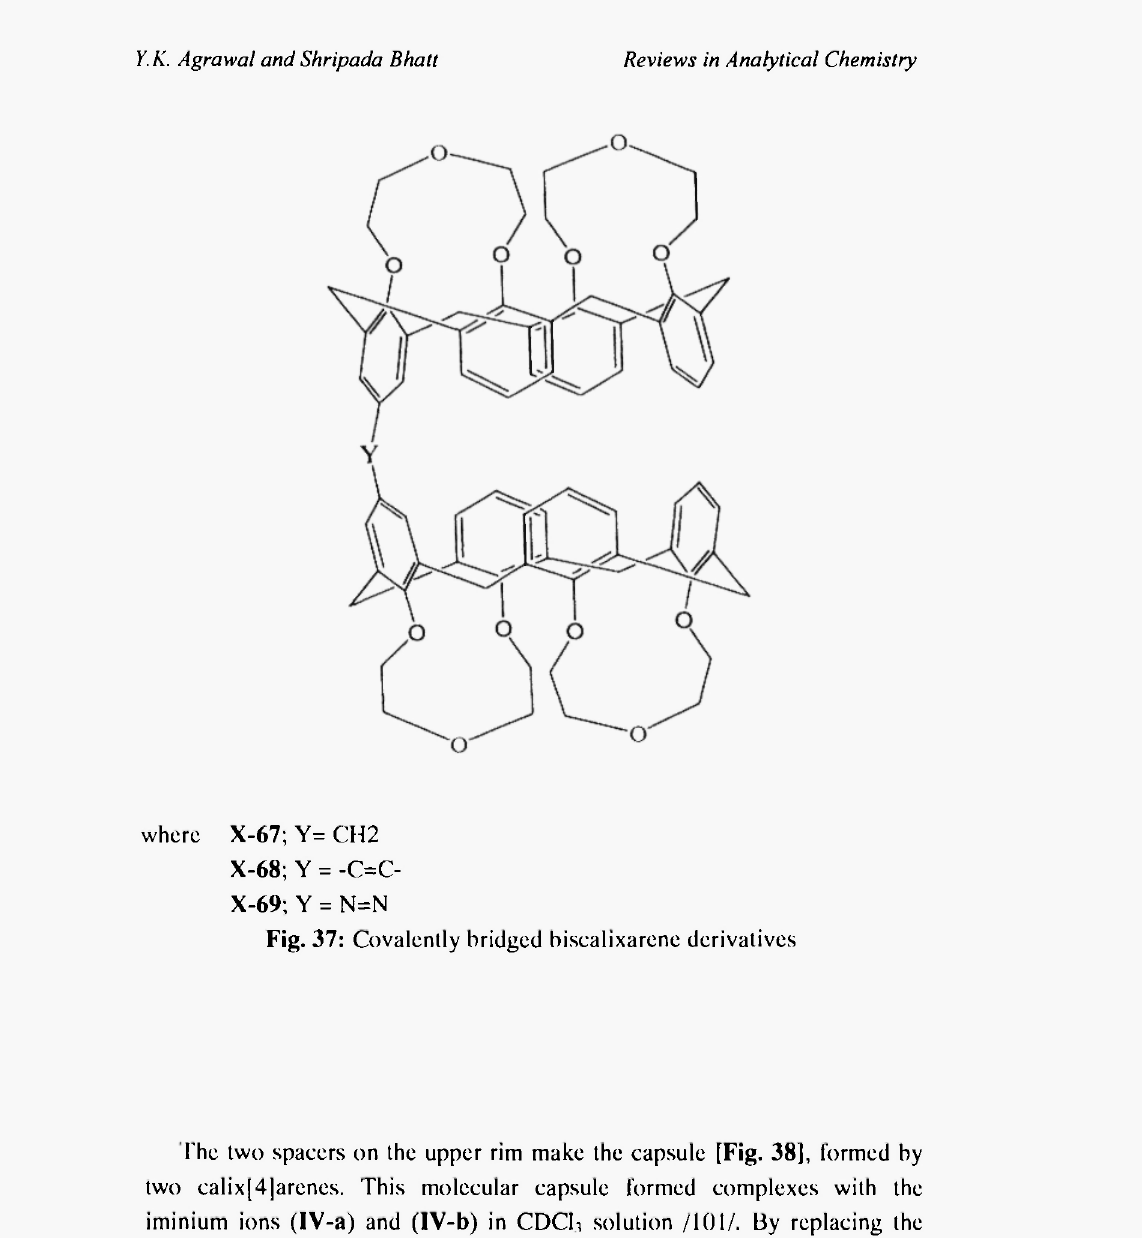
The two spacers on the upper rim make the capsule [Fig. 38], formed by two calix[4]arenes. This molecular capsule formed complexes with the iminium ions (IV-a) and (IV-b) in CDCIT solution /101/. By replacing the propyl groups in this compound by hydrogen, the π-basicity of the aromatic- cavity is increased /102/; consequently, the association constant with I is increased to 5 χ 1() Λ Μ' 1